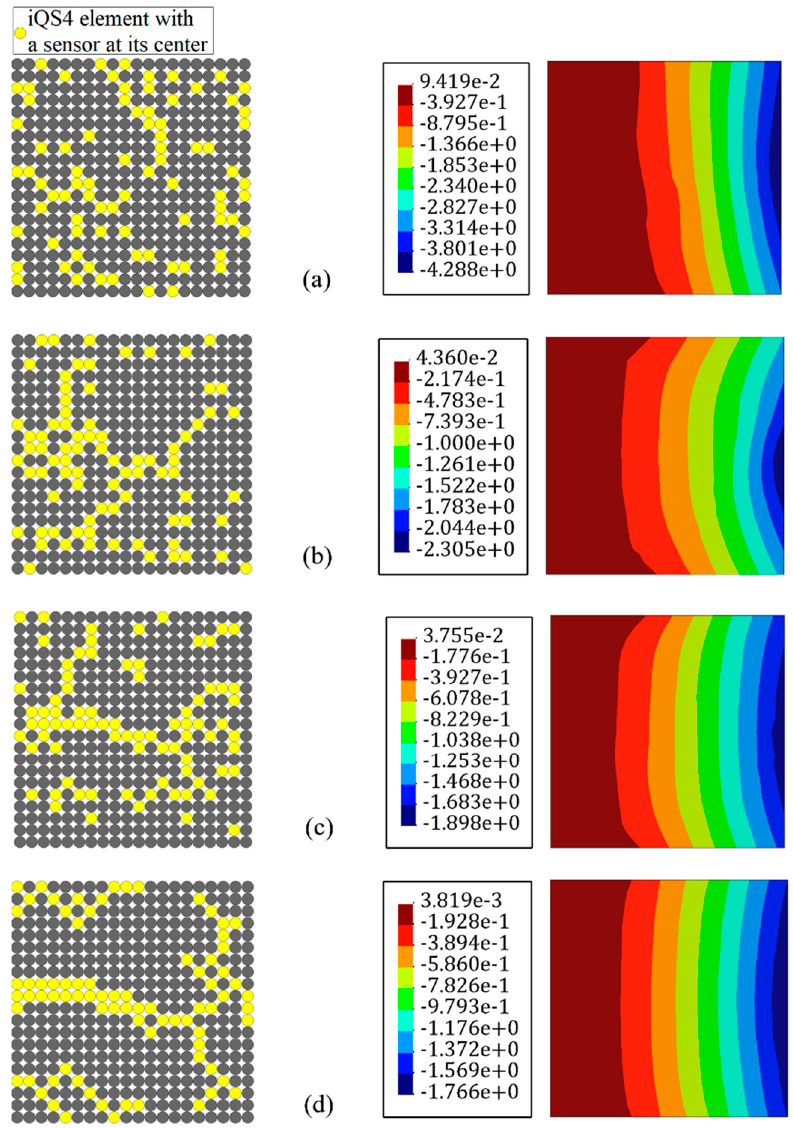
Figure 7. Reconstruction of the transverse displacement with reduced sensors in the iFEM-GA method after ( a ) the first generation, ( b ) 20 generations, ( c ) 50 generations, ( d ) 200 generations.